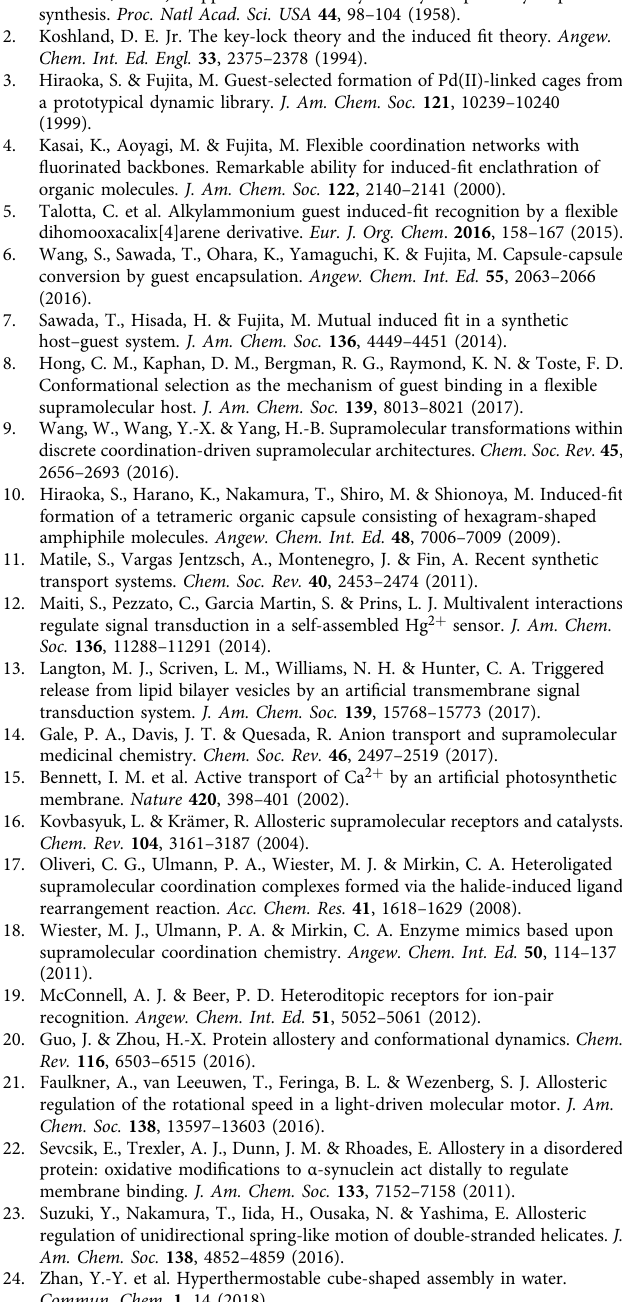
Data availability The authors declare that all the other data supporting the fi ndings of this study are available within the Article and its Supplementary Information fi les and from the corresponding author upon